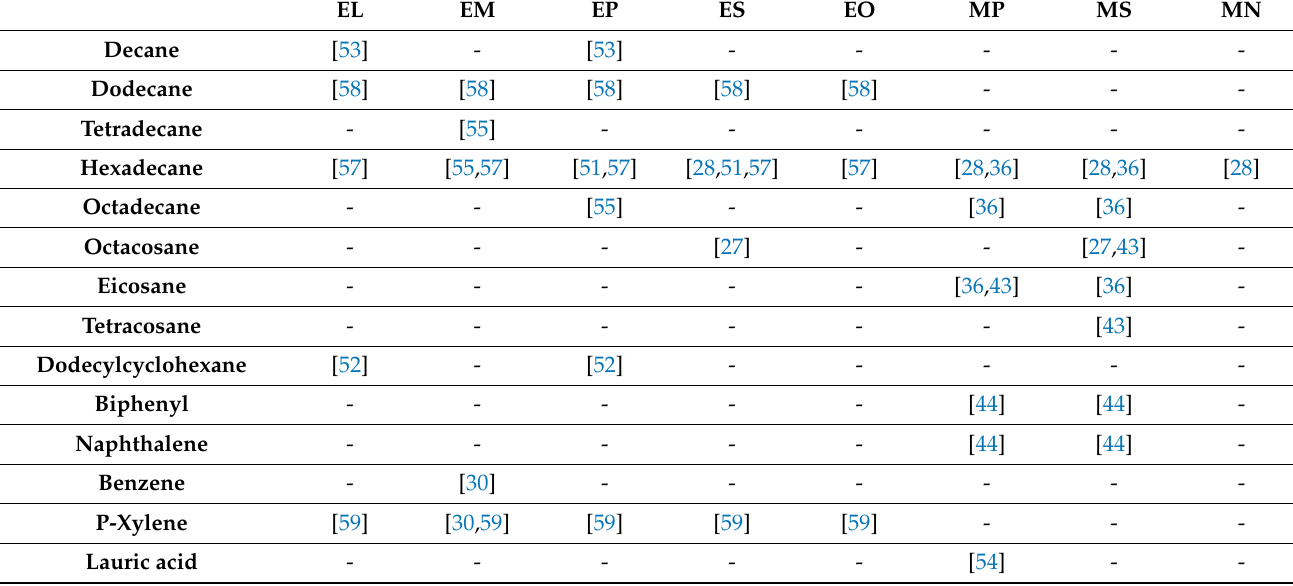
Table 7. References described in Section 2.4, ordered by the two compounds of the mixture 1